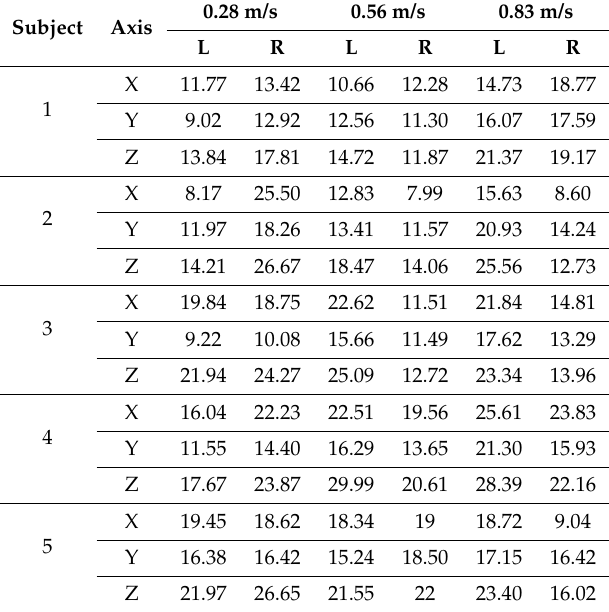
Table 2. RMSE between the proposed and the reference system.